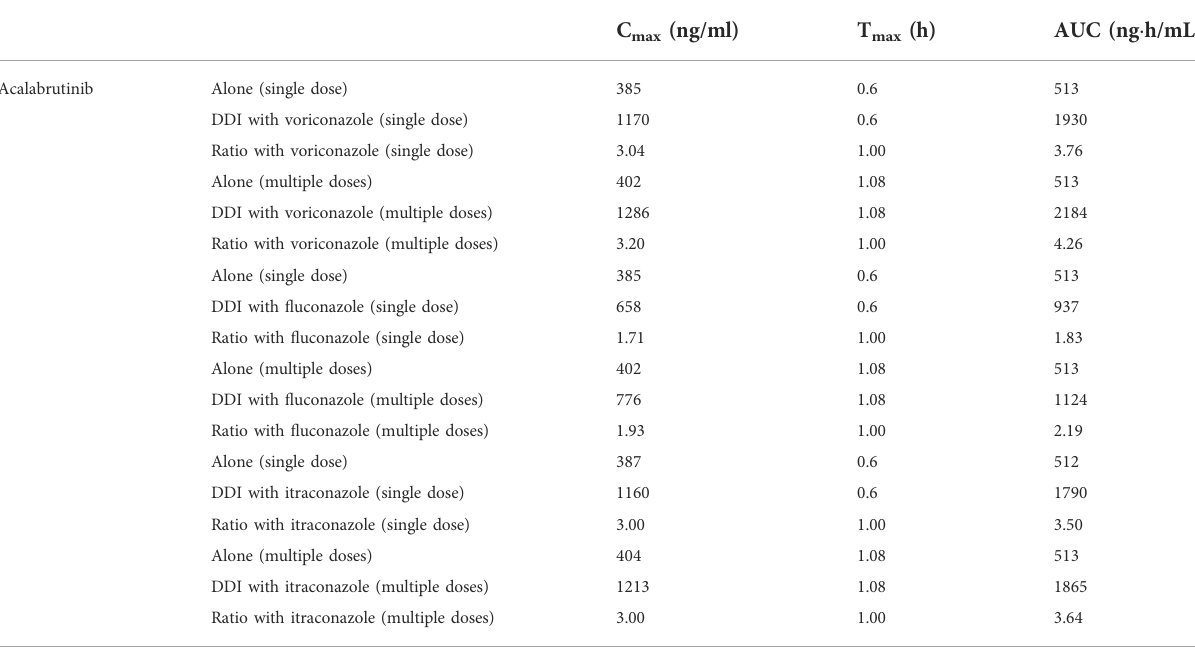
TABLE 4 Model-predicted PK parameters and ratios of acalabrutinib given alone and with triazoles.